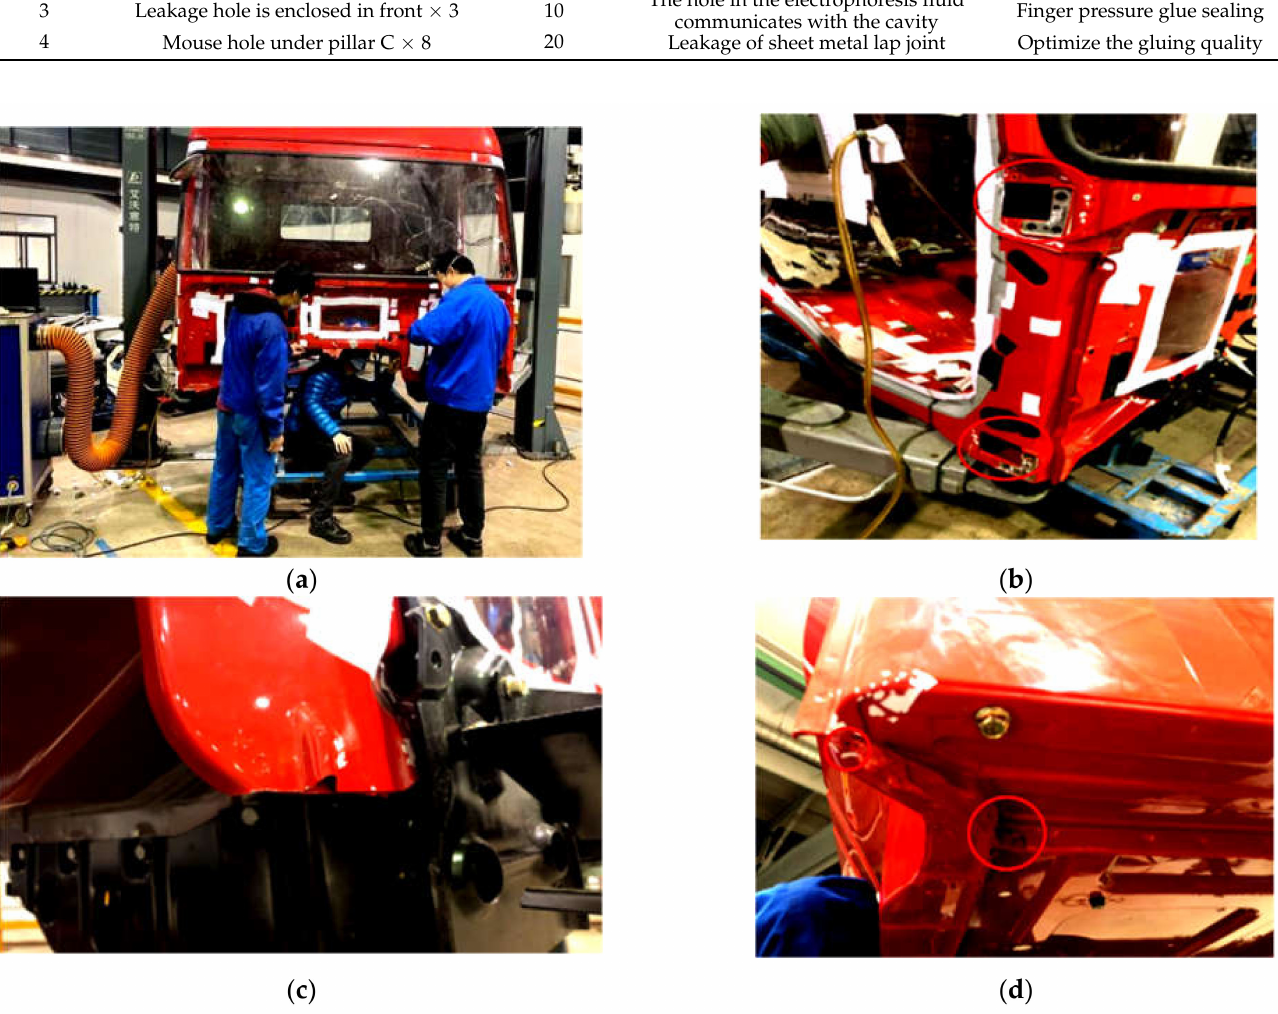
Figure 15. The cab sealing test. ( a ) Seal of cab; ( b ) Seal measuring point; ( c ) Cab bottom measuring point; ( d ) Measuring point of